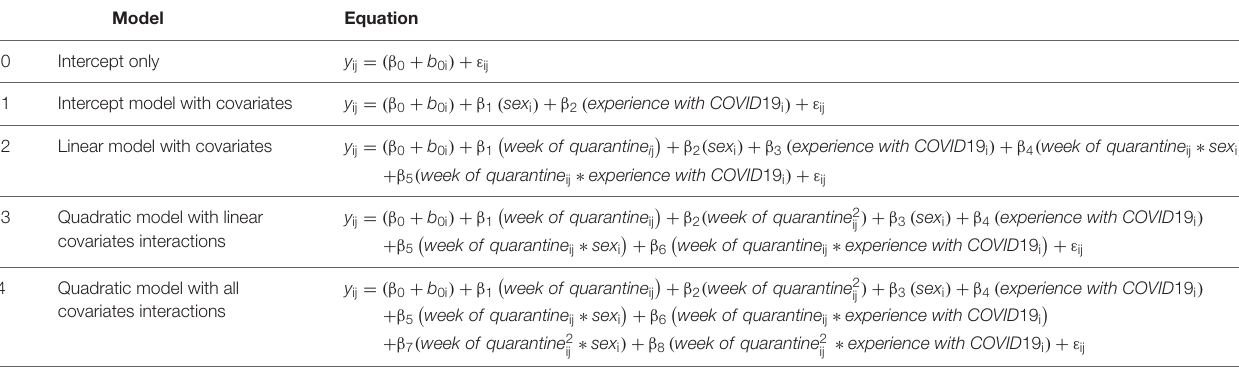
TABLE 2 | Equations of each estimated